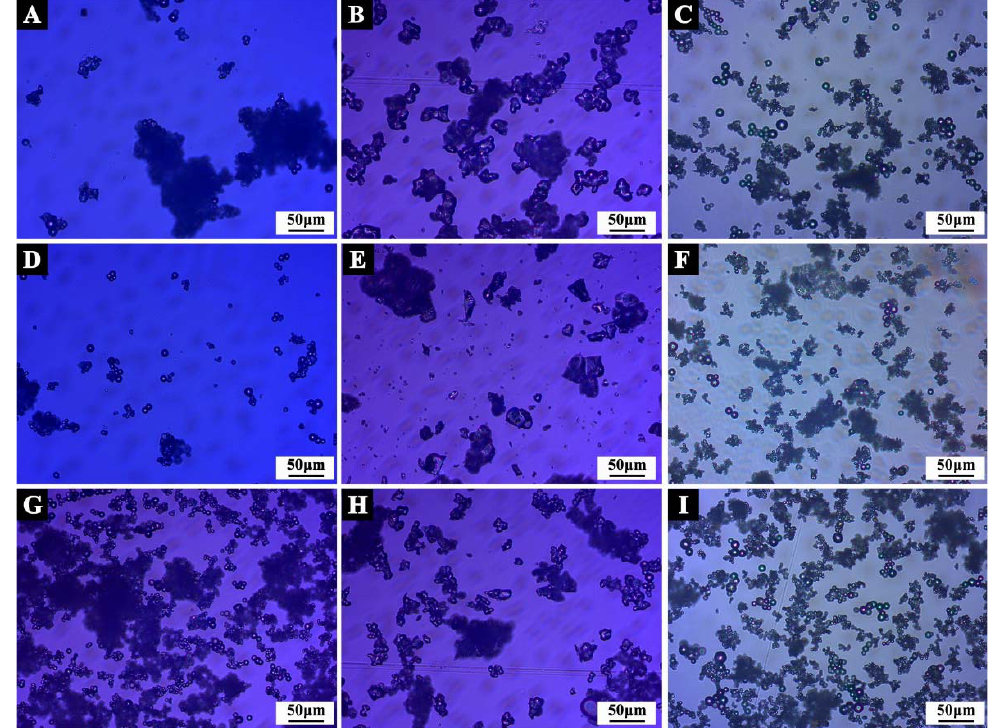
Figure 4. OM of microcapsules under orthogonal test parameters: ( A ) sample #1; ( B ) sample #2; ( C ) sample #3; ( D ) sample #4; ( E ) sample #5; ( F ) sample #6; ( G ) sample #7; ( H ) sample #8; ( I ) sample #9.